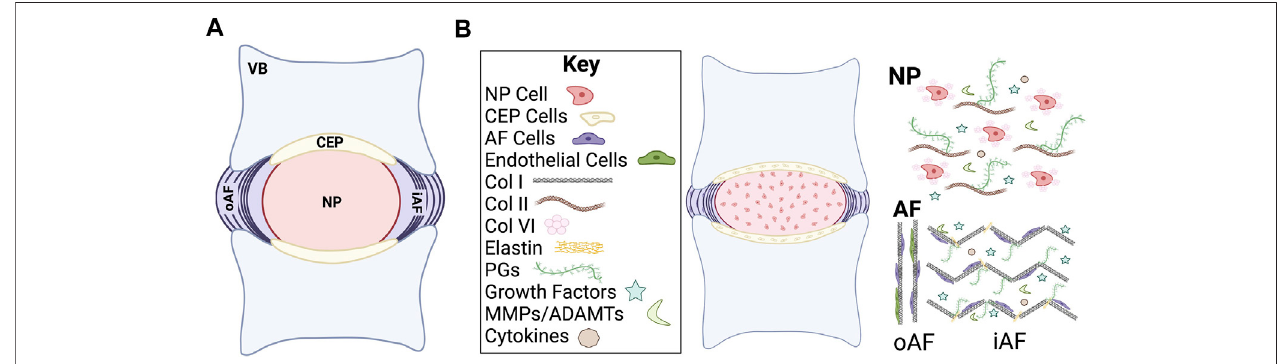
FIGURE 1 | Schematic of intervertebral disc (IVD) structure. (A) Midsagittal cut plane of the IVD. (B) Overview of general cellular and chemical composition of the IVD. VB, vertebral body; CEP, cartilage endplate; NP, nucleus pulposus; oAF, outer annulus fi brosus; iAF, inner annulus fi brosus; Col, collagen; PGs, proteoglycans; MMPs, matrix metalloproteases; ADAMTs, a disintegrin and metalloproteinase with thrombospondin